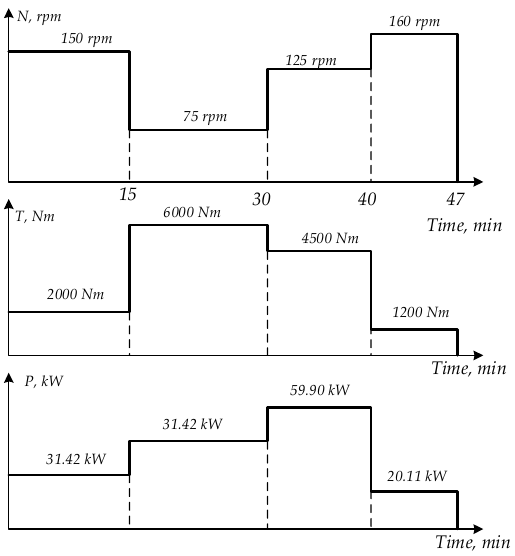
Figure 11. Vehicle loading diagram. It is an example only.